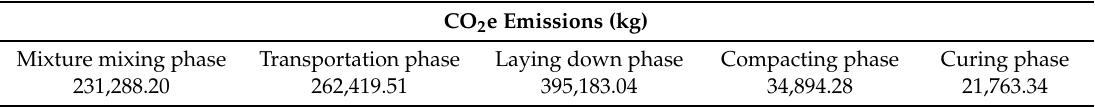
Table 7. GHG emissions for construction of cement stabilized aggregate